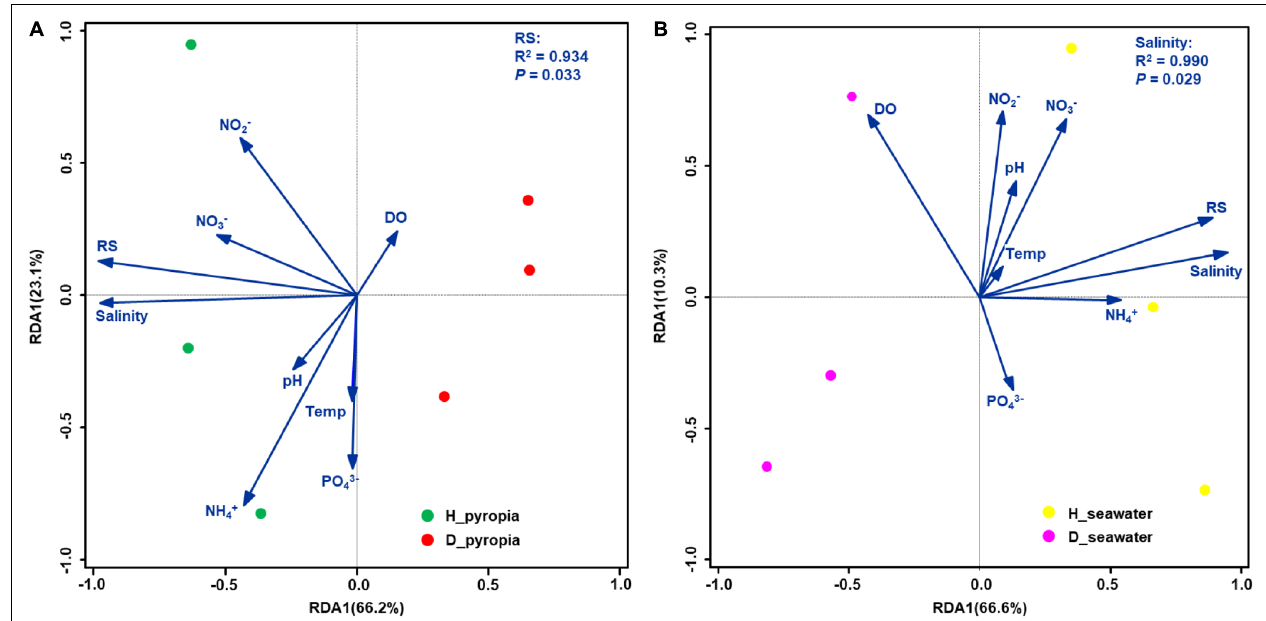
FIGURE 6 | Biplots of redundancy analysis (RDA) for bacterial communities and environmental parameters. Community datasets associated with Pyropia yezoensis (A) and seawater (B) were used. Temp, temperature; DO, dissolved oxygen; RS, reactive silicate.